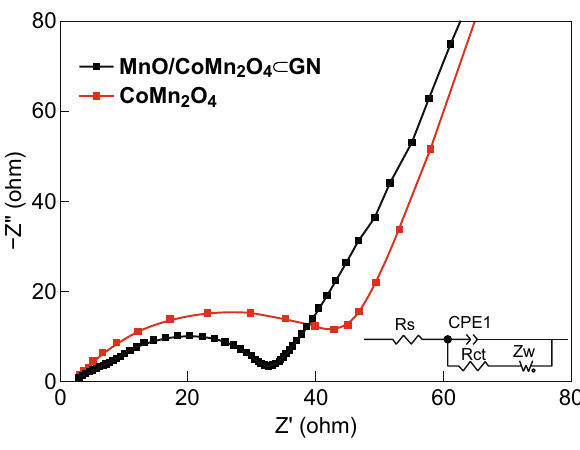
Fig. 6 Electrochemical impedance spectroscopy plots of pure CoMn 2 O 4 and MnO/CoMn 2 O 4 ⊂ GN